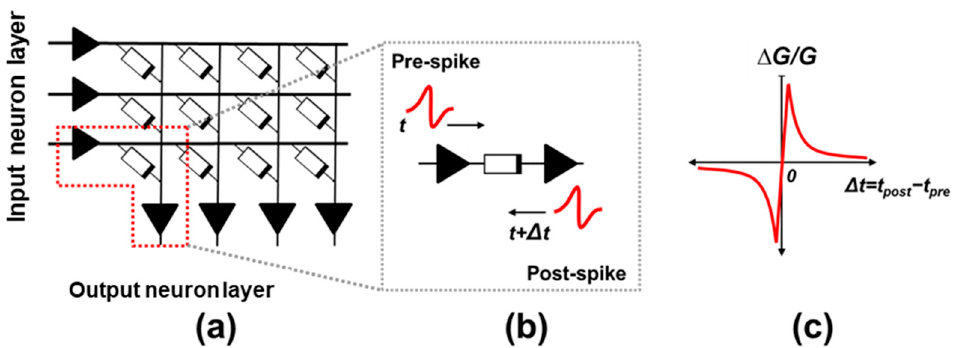
Figure 2. ( a ) Neuromorphic memristive array. Each node within the crossbar corresponds to the weighted connection (synapse) between two neurons, implemented with a memristor. ( b ) The conductivity of the device can be changed according to the activity of the neurons it connects. ( c ) STDP function.